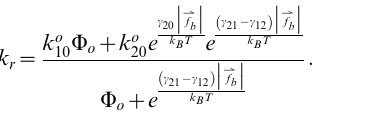
so both (1) and (2) would yield the same average reaction rate across the contact patch for a sphere touching the wall to within surface roughness limitations.